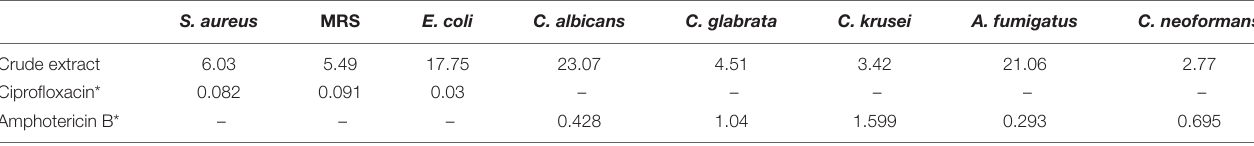
TABLE 1 | IC 50 Values of the Crude Ethanol Extracts of Monanchocidin A in µ g/mL.